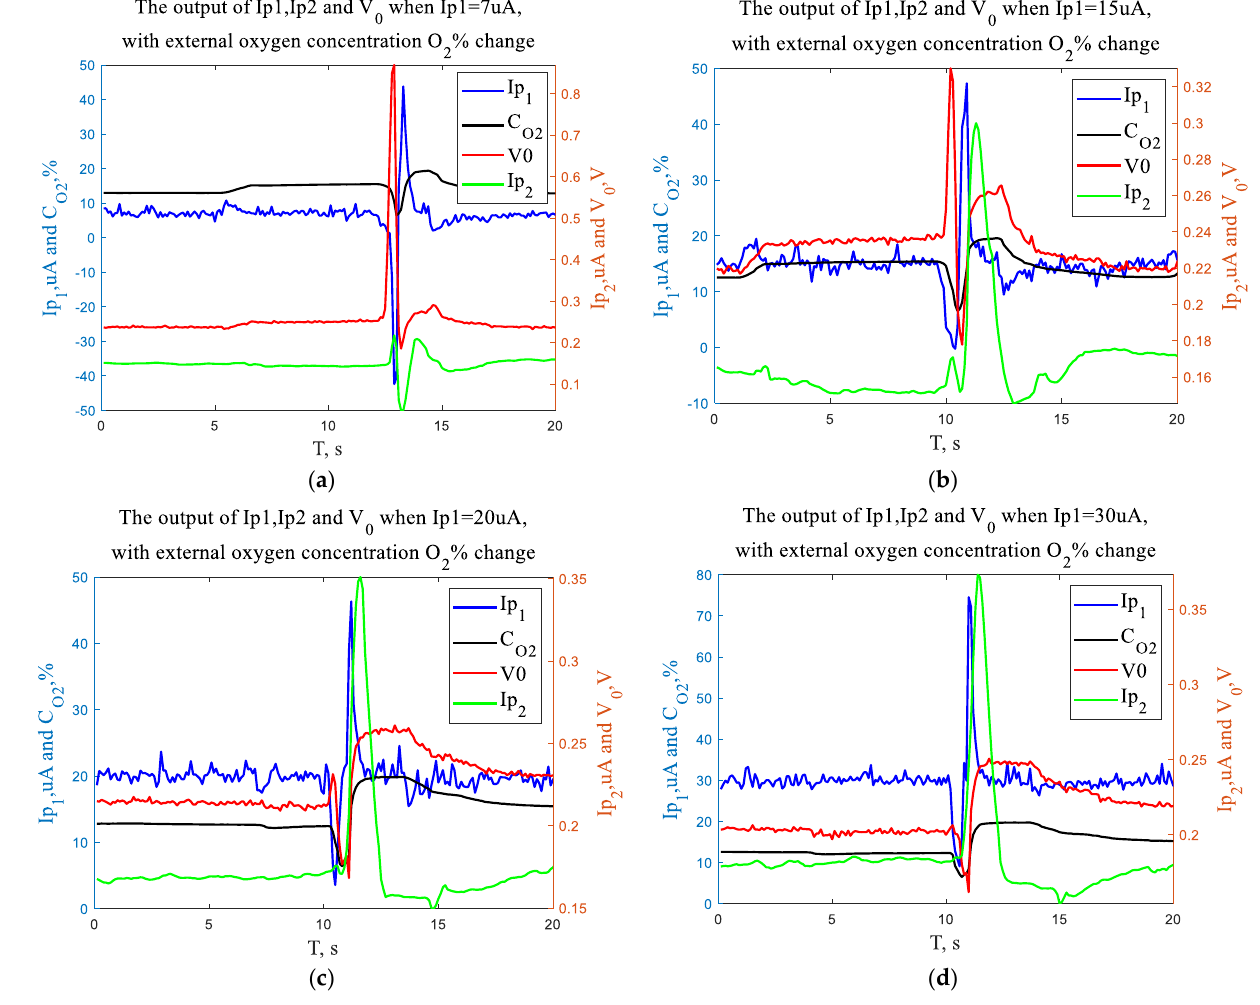
Figure 13. The outputs of Ip 1 , Ip 2 , and V 0 when the oxygen concentration interference amplitude was the same. Table 2. Ip 1 set point for different structure sizes of the second diffusion channel.